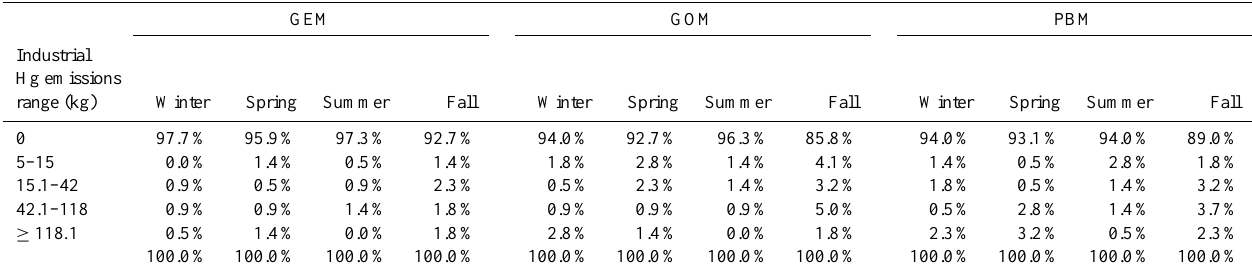
Table 3. Percentage of major source areas ( ≥ 90th percentile seasonal CWTs for GEM, GOM, and PBM) associated with different ranges of industrial Hg emissions (25th, 50th, 75th percentile) in each grid cell. GEM GOM